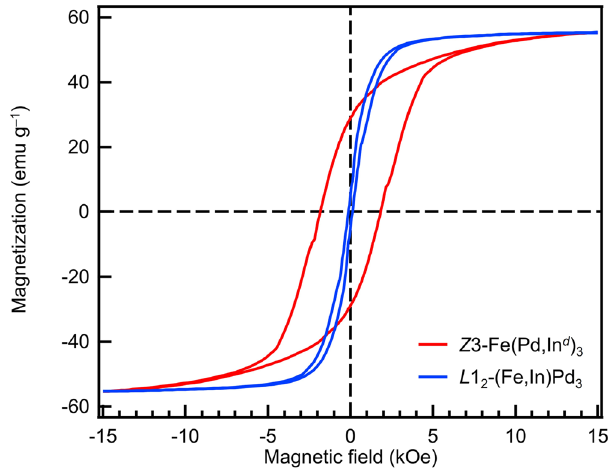
Fig. 4 Magnetic properties of L 1 2 -(Fe,In)Pd 3 and Z 3-Fe(Pd,In d ) 3 NPs. M – H hysteresis loop of Z 3-type NPs (Pd/In = 83/17 at.%) and L 1 (Pd/In = 89/11 at.%) measured by VSM at room